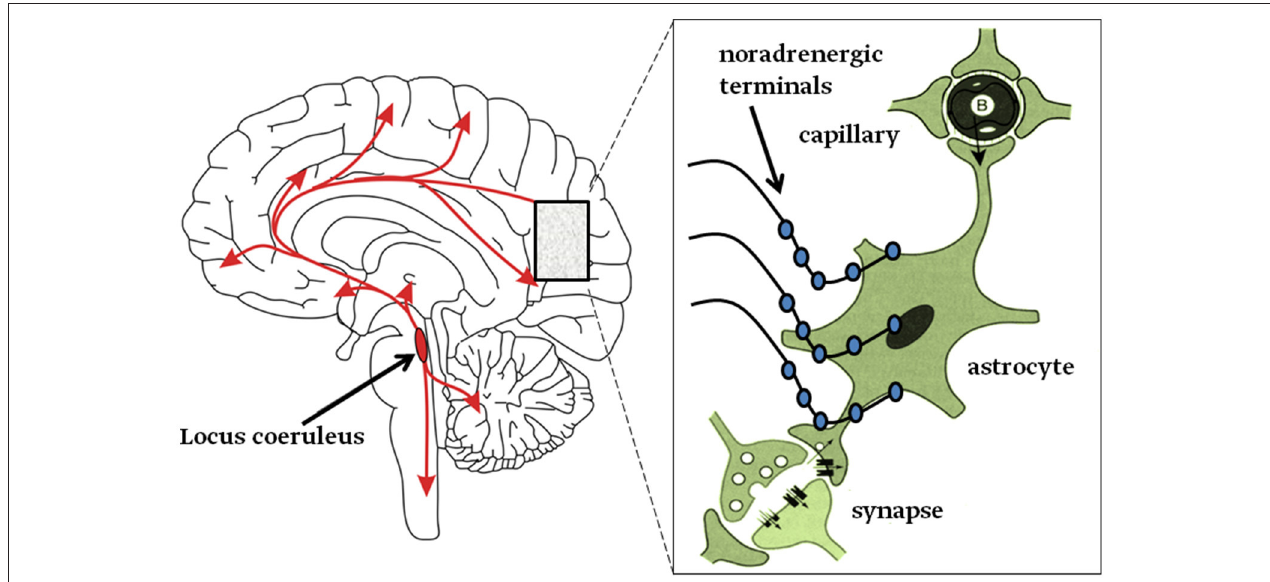
FIGURE 2 | Graphical abstract. Left : neurons from the Locus coeruleus (LC) project axons to most, if not all, areas of the brain and into the spinal cord as denoted by the arrows. Right : inset magnifies the LC nerve endings with varicosities (swellings on noradrenergic nerve terminals) from which NA is released and mainly activates astroglia ( Aoki, 1992; Sherpa et al., 2016). About half of these terminals do not form tight contacts with target cells, resembling synapses (Feinstein et al.,